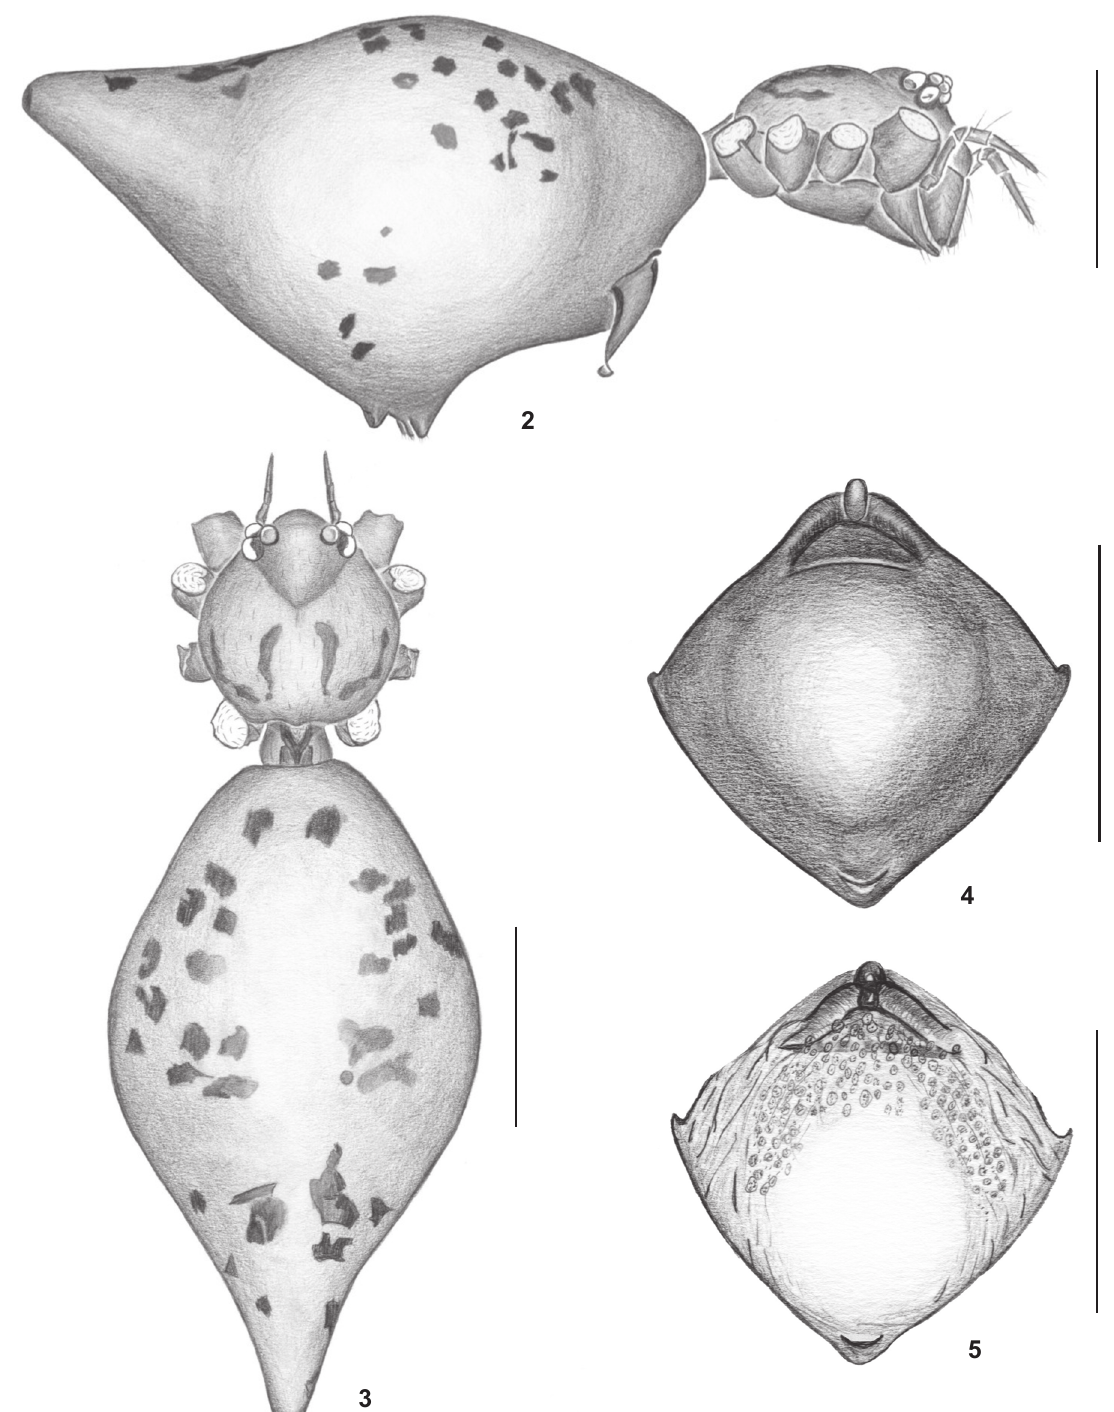
Figures 2-5. Metagonia taruma , female: (2-3) habitus, lateral (2) and dorsal (3) views; (4-5) cleared female genitalia, ventral (4) and dorsal (5) views. Scale bars: (2-3) 1 mm, (4-5) 0.5